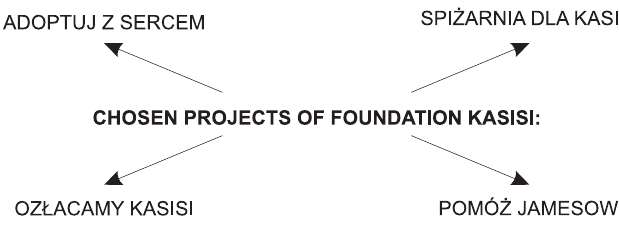
Source: own study based on: Fundacja Kasisi , http://www.fundacjakasisi.pl/,